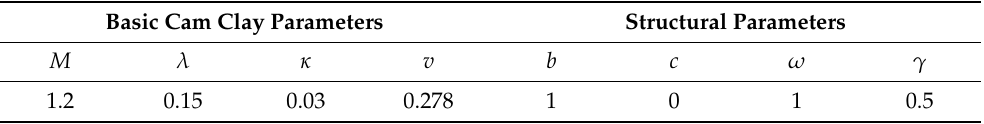
Table 1. Soil property parameters used in calculation.